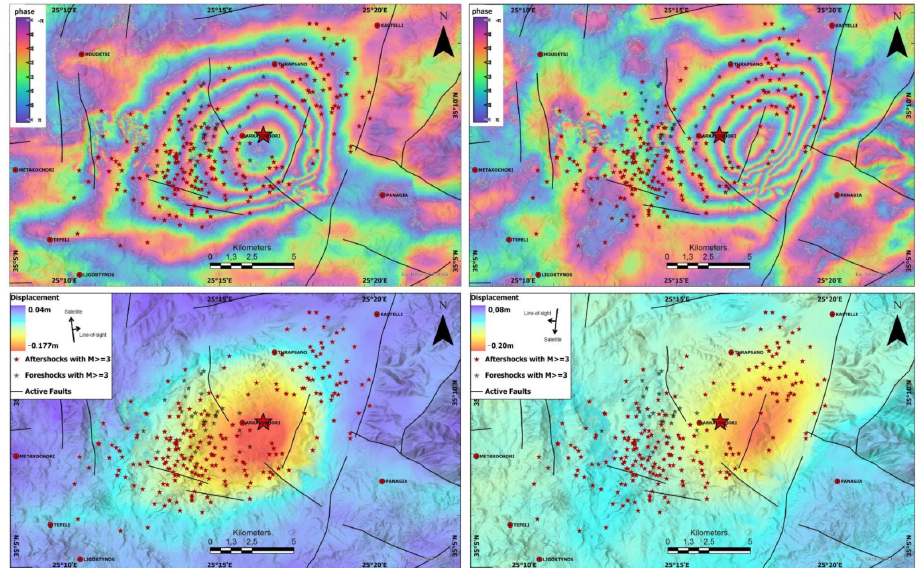
Figure 10. Upper maps: wrapped ascending ( left ) and descending ( right ) co-seismic interferograms over the Arkalochori area. The interferograms are draped over shaded relief. Lower maps: co-seismic displacement maps generated using the ascending and the descending image pairs and draped over shaded relief. Appl. Sci. 2022 , 12 , x FOR PEER REVIEW The LoS displacement map in the ascending geometry shows negative LoS dis- placement values up to 18 cm, after the Mw = 6.0 earthquake including the ground de- formation caused by all the seismic events that occurred in the time interval from 23 September to 29 September, (Figure 10, lower part), while the LoS displacement map in the descending geometry shows negative LoS values up to 20 cm after the Mw = 6.0 earthquake, including all the aftershocks, occurred until the 1st of October. On the de- scending orbital geometry, the maximum value of ground deformation has shifted east of the epicenter of the main earthquake (Figure 10) with respect to the ascending displace- ment map. After the decomposition of ascending and descending LoS displacement maps, the ground deformation in vertical (up–down) and east–west directions were ex- tracted (Figure 11a). Subsidence up to 18 cm has been calculated from the displacement decomposition in the vertical (up–down) direction while no uplift was detected. The horizontal (east-west) displacement map reveals an eastward motion up to 6 cm in the area west of the epicenter and a westward movement up to 7.6 cm for the area east of Arckalochori (Figure 11b). The latter is in satisfactory agreement with [21] where the displacement is associated with the horizontal motion of the strike-slip component of the mean event focal mechanism.